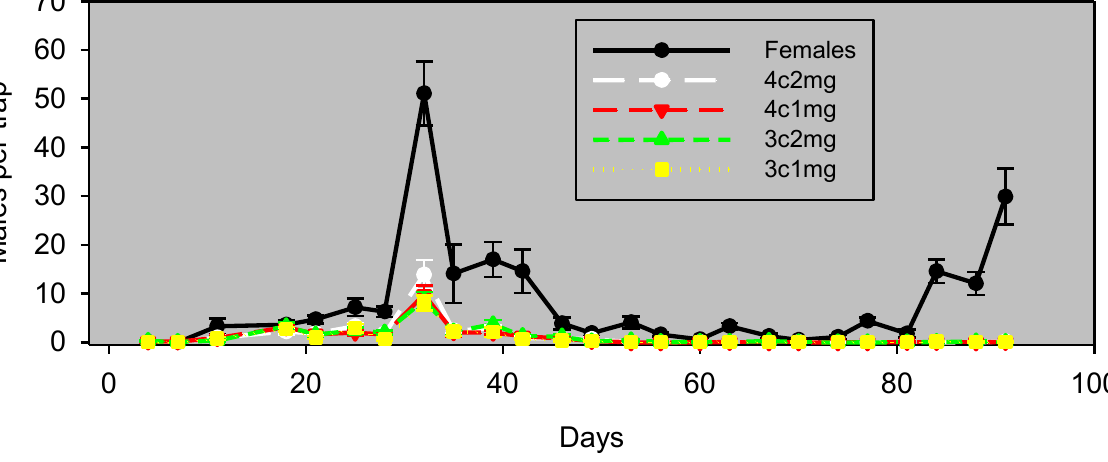
Figure 3. Experiment 2: males captured (mean ± SE) in pistachios, by monitoring the interval in wing traps baited with unmated females or artificial lures, starting March 29, 2012. Blocks were 37 m apart, and traps within blocks were 18 m apart. The lure preparation is as in Table